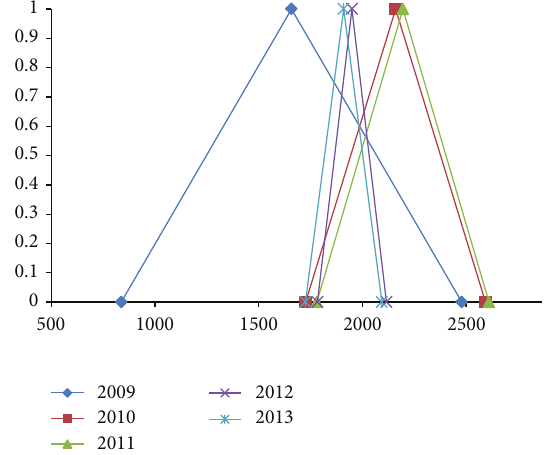
Figure 2: Historical zinc metal prices expressed as triangular fuzzy